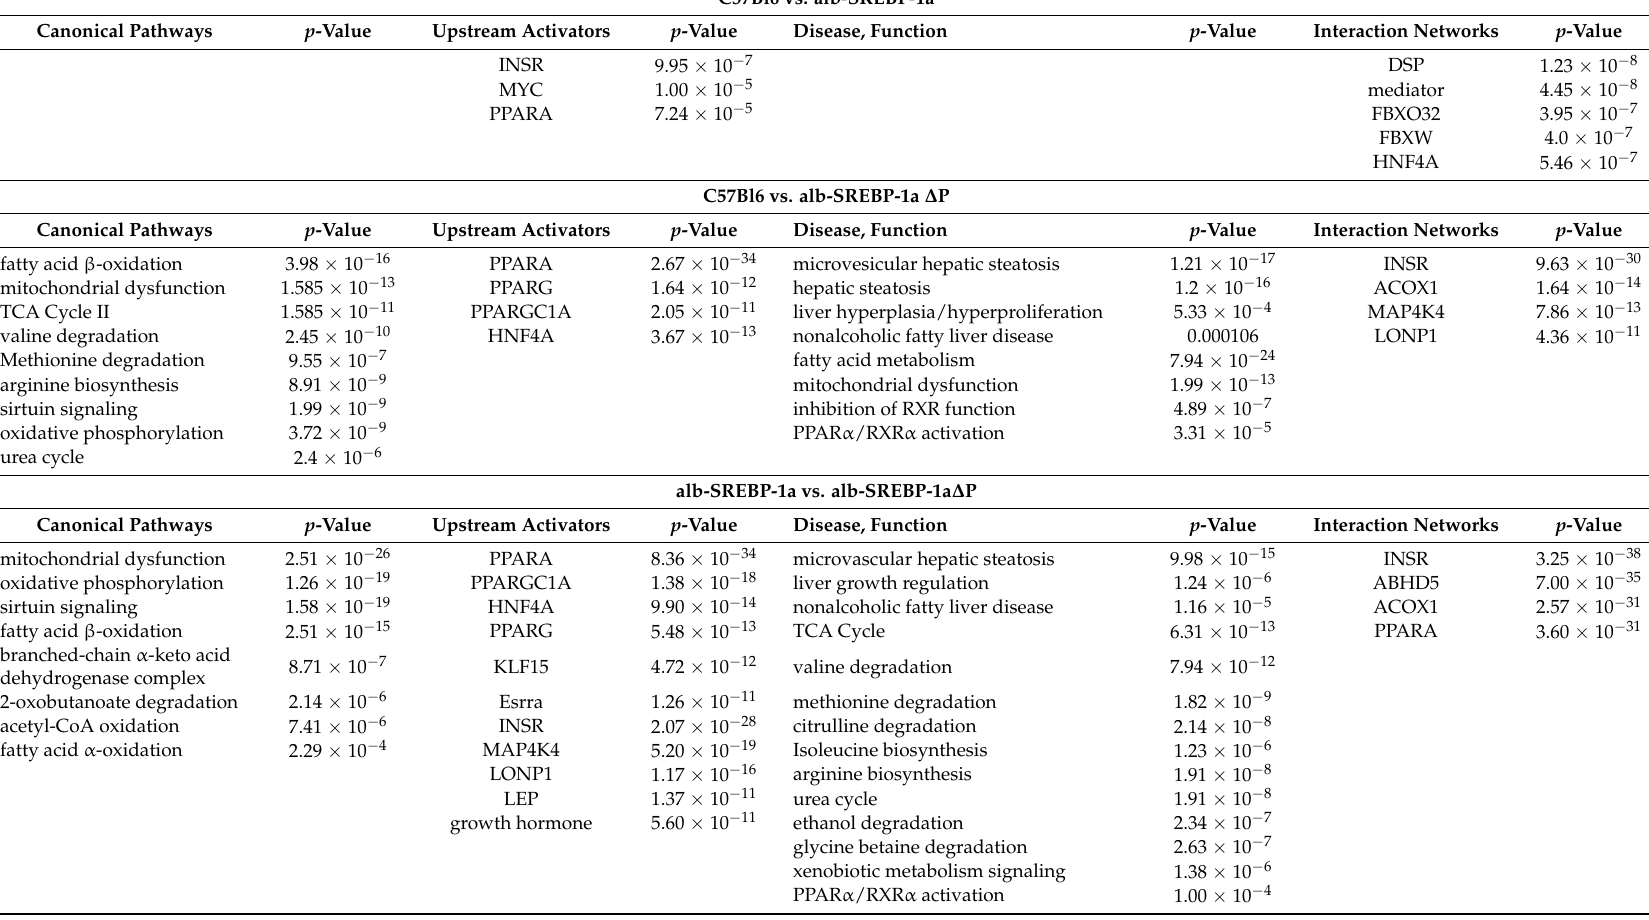
Table 3. Differential peroxisomal proteome and core analyses of the comparisons C57Bl6 vs. alb-SREBP-1a, C57Bl6 vs. alb-SREBP-1a ∆ P and alb-SREBP-1a vs. alb-SREBP-1a ∆ P. Examples as listed in text. p -value: p -value for enrichment of pathway molecules in the data set. Complete analyses are given in Tables